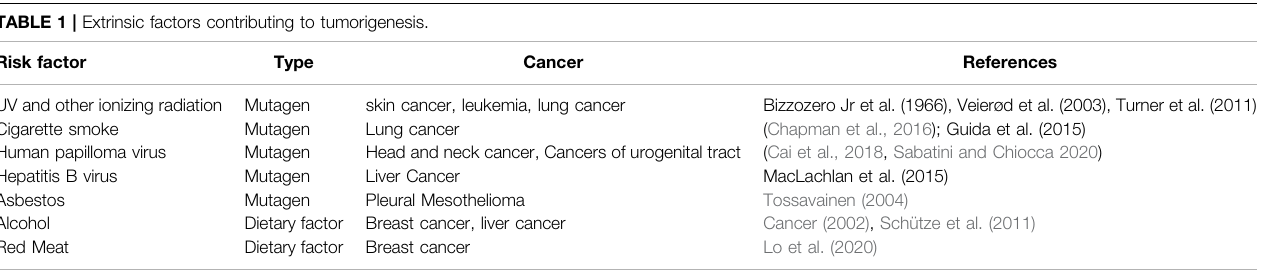
TABLE 1 | Extrinsic factors contributing to